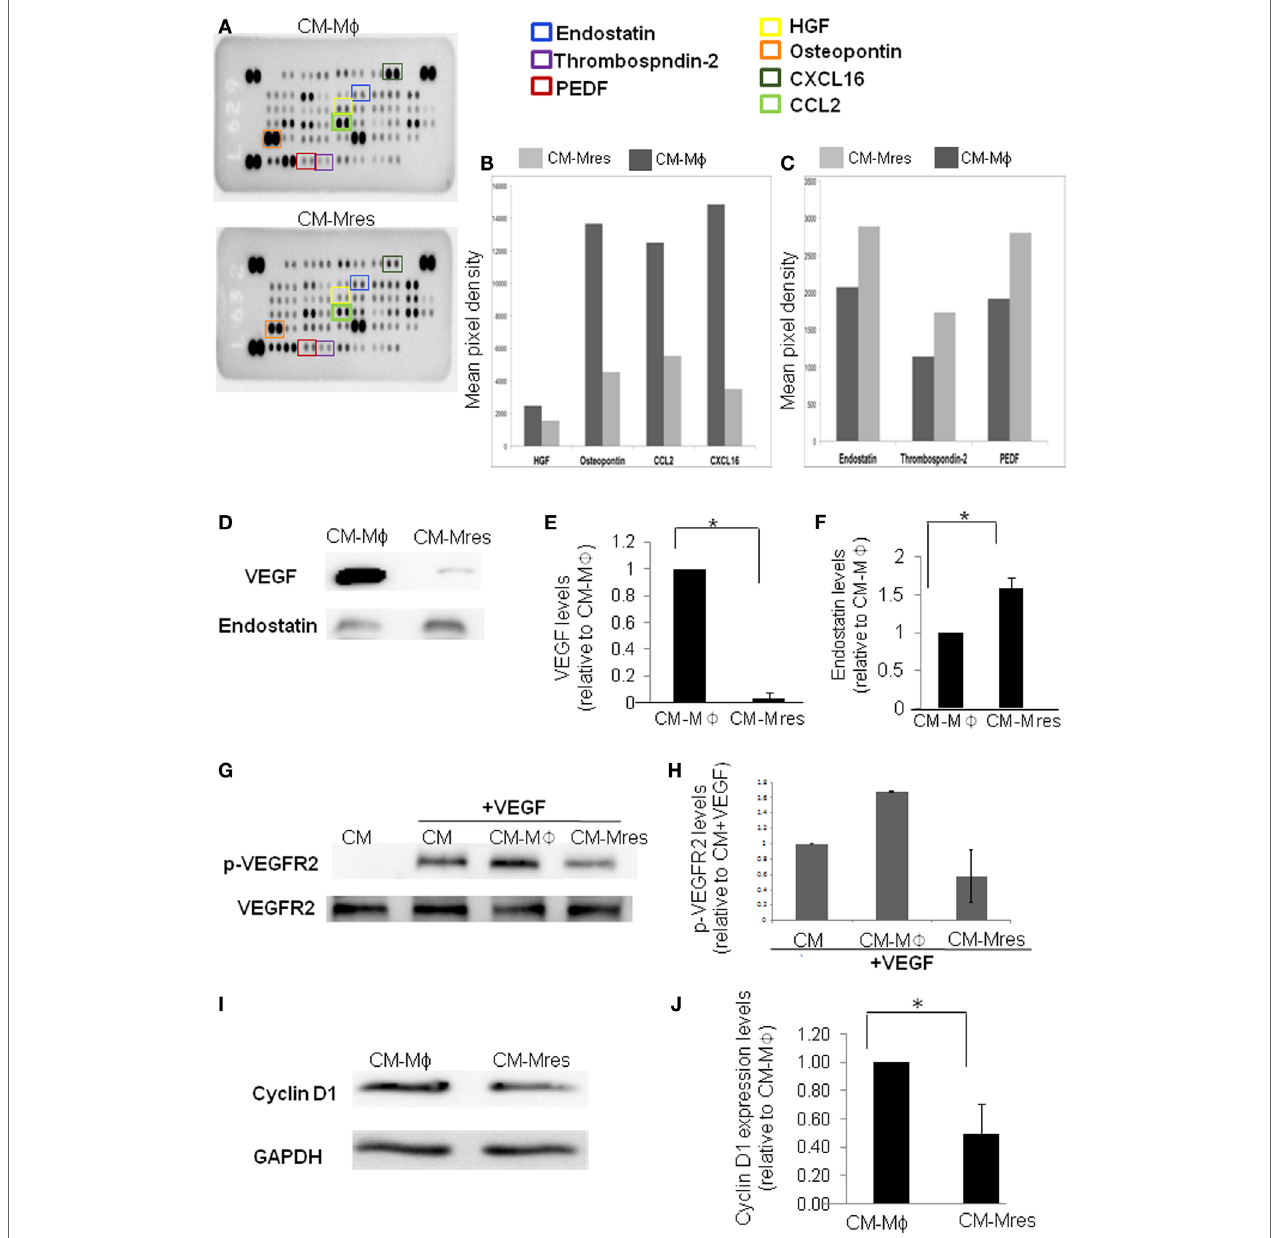
FigUre 5 | Antiangiogenic factors levels are higher in CM-Mres compared with CM-M ϕ . (a) The Proteome Profiler Mouse Angiogenesis Array Kit (Catalog # ARY015) was used to simultaneously assess the relative levels of 53 mouse angiogenesis-related proteins in either CM-M ϕ (upper panel) or CM-Mres (lower panel). (B) Quantification of pro-angiogenic factors; HGF, osteopontin, CXCL16, and CCL2. (c) Quantification of antiangiogenic factors; endostatin, thrombospondin-2, and PEDF. The histograms (B,c) were generated by quantifying the mean spot pixel density from the arrays using image software analysis. (D) Representative western blot analysis of vascular endothelial growth factor (VEGF) and endostatin levels in CM-M ϕ compared with CM-Mres. (e,F) Quantification of VEGF (e) and endostatin levels (F) . Densitometry values in panels (e,F) were normalized to CM-M ϕ . n = 3, t -test, * p < 0.05. (g) Representative western blot of VEGFR2 phosphorylation in human umbilical vein endothelial cell (HUVEC) induced by VEGF (25 ng/ml) in the presence of the different conditioned media and its quantification (h) . (h) Densitometry values of p-VEGFR2 were normalized to treatment with condition medium (CM) + VEGF ( n = 2). Columns; mean, bars; STD. (i) Representative western blot of cyclin D1 expression levels in HUVEC treated with either CM-M ϕ or CM-Mres and its quantification (J) . (J) Densitometry values were normalized to treatment with CM-M ϕ . Columns; mean, bars; STD, n = 3, t -test, * p < 0.05.